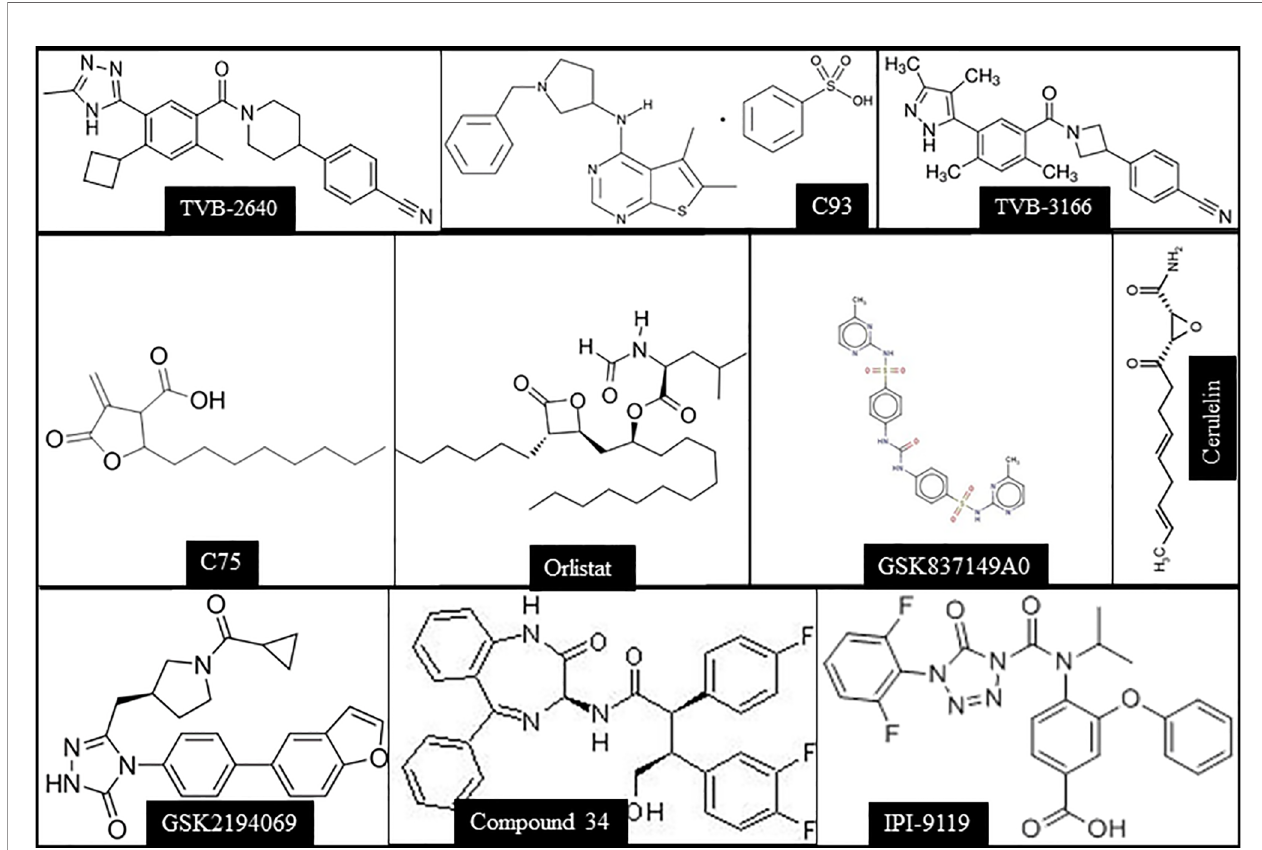
FIGURE 3 | Chemical structures of the main FASN inhibitors tested in preclinical and clinical studies.